Question: Write a descriptive caption for this figure.
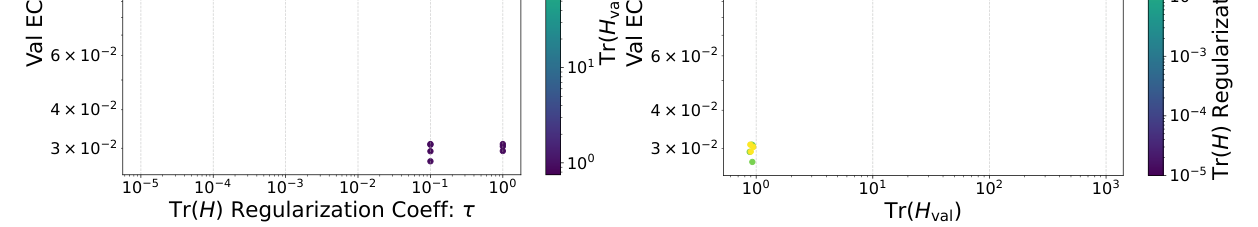
Answer: This figure presents the results of training a 2-layer MLP with hidden-size 100 on CIFAR10 using a loss function that explicitly incorporates Tr(Hval) regularization. Each data point corresponds to a different learning rate and τ value. Higher τ values resulted in lower ECE and smaller Tr(Hval), while lower τ values led to higher ECE and Tr(Hval).